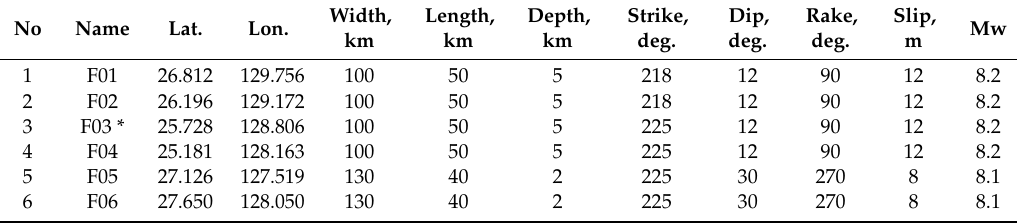
Figure 3. The fault scenario around Okinawa Island that was selected to evaluate the tsunami hazard. The study area is in the green box, which is represented by the 90 m grid size for the inundation computation. Table 1. Fault parameters for earthquake scenarios used to generate tsunami.